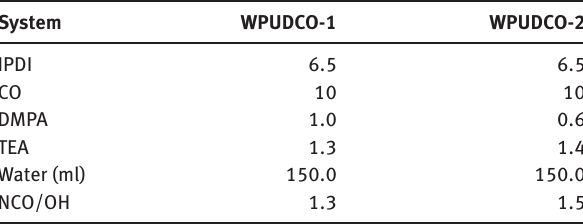
Table 2: Nomenclature of the polyurethane aqueous dispersions with different NCO/OH